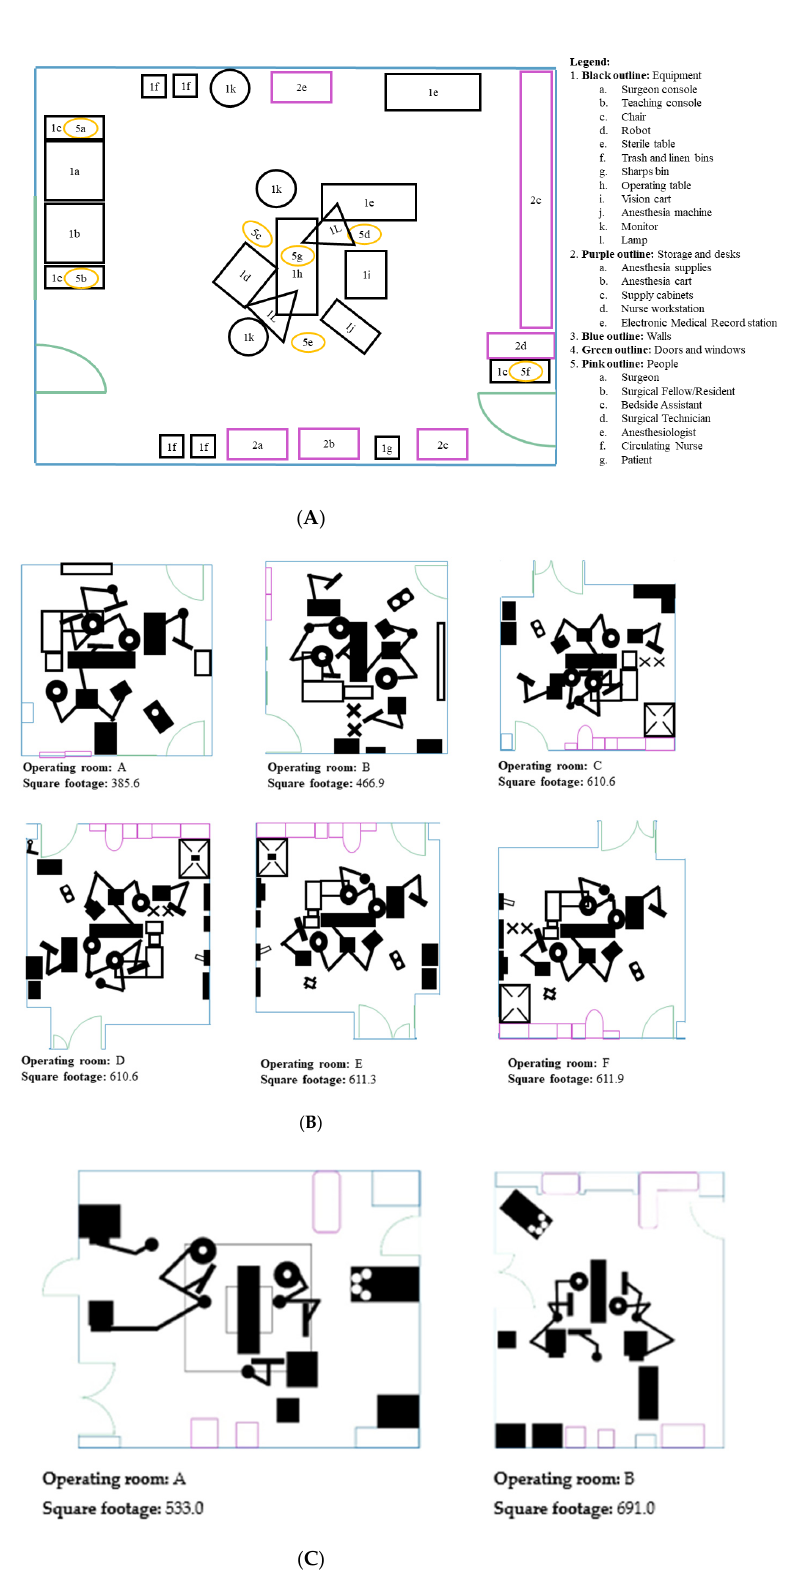
Figure 2. ( A ) A mock-up of an RAS OR during the on-console phase to demonstrate a general layout of a robotic operating room, ( B ) operating room floor plans for site 1, ( C ) operating room floor plans for site